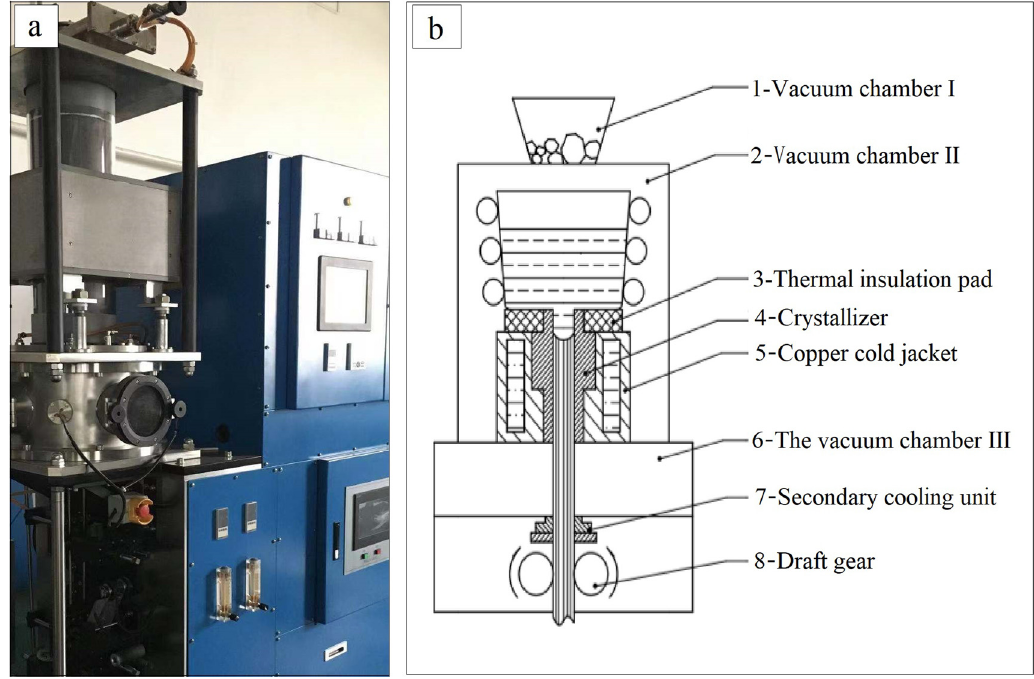
Figure 1: Three - chamber vacuum cold mold vertical drawing continuous casting device ( a ) and its schematic diagram ( b )